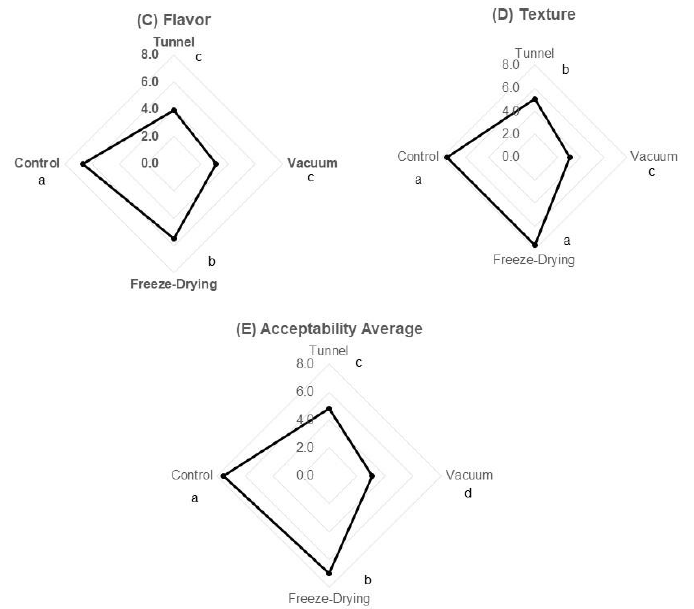
Figure 3. Sensory evaluation of reconstituted yogurt. The figure shows scores of ( A ) appearances, ( B ) odor, ( C ) flavor, ( D ) texture, and ( E ) acceptability average. The yogurt obtained by freeze-drying method presented the highest score, while the one obtained by vacuum method showed the lowest. Different letters (a, b, c, d) show significant